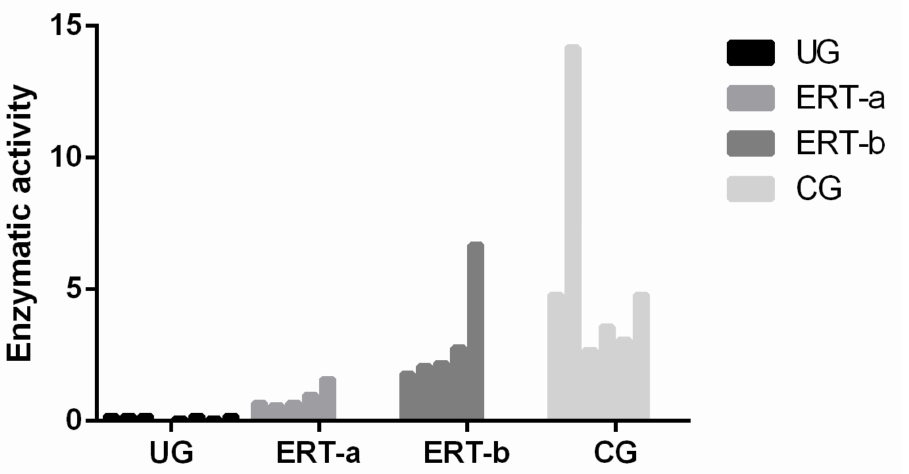
Figure 15. Enzyme activity of GALNS. CG, control group; ERT-a, MPS IVA patients sampled 1 day before ERT; ERT-b, MPS IVA patients sampled 24 h after ERT; UG, untreated